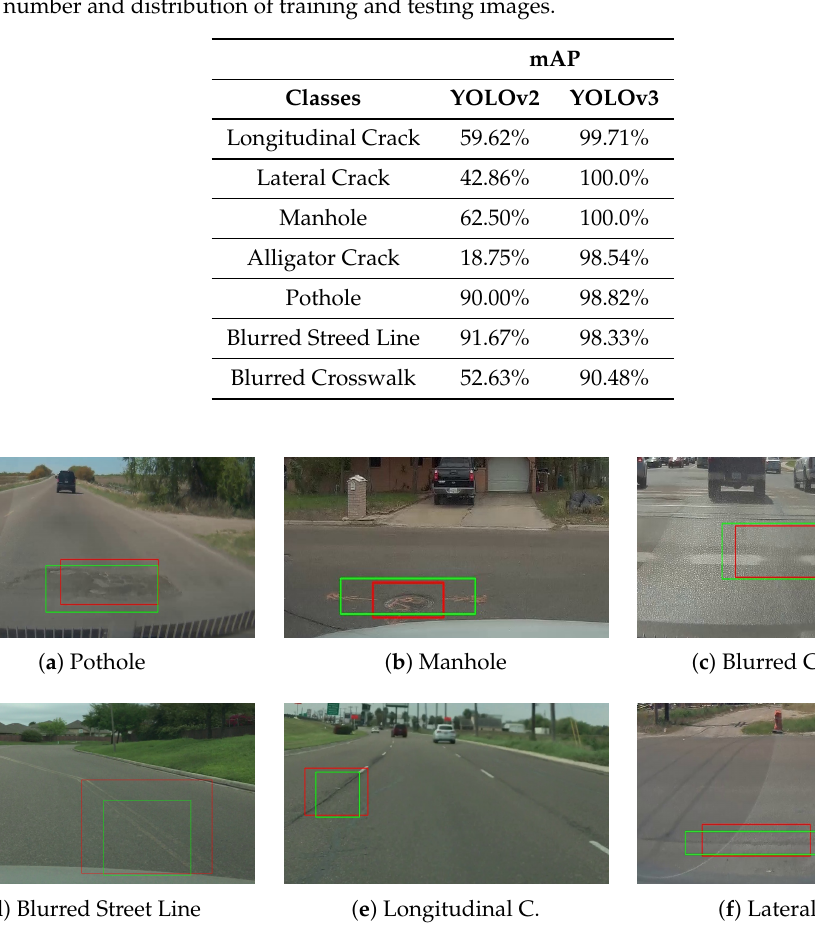
Figure 5. Examples of true positive predicted bounding boxes, the box in red is the ground truth, and the box in green represents the predicted bounding